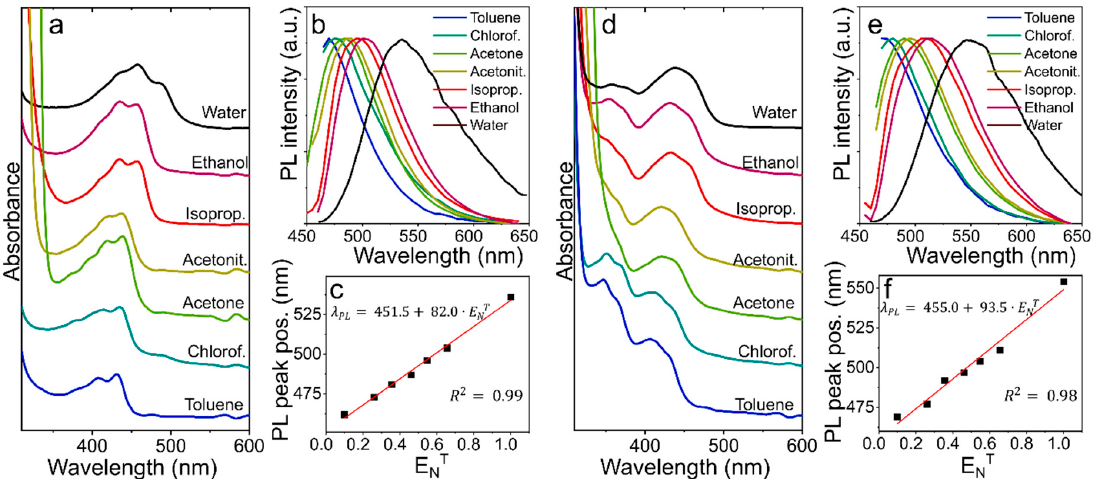
Figure 3. Dependence of optical properties on solvent polarity for CD-w ( a – c ) and CD-TU ( d – f ). ( a , d ) Absorption spectra. ( b , e ) Normalized PL spectra excited at 450 nm. ( c , f ) PL peak position (excited at 450 nm) depending on normalized solvent polarity (E T ) of the solvent. The linear fit is shown by straight red lines. See the main text for